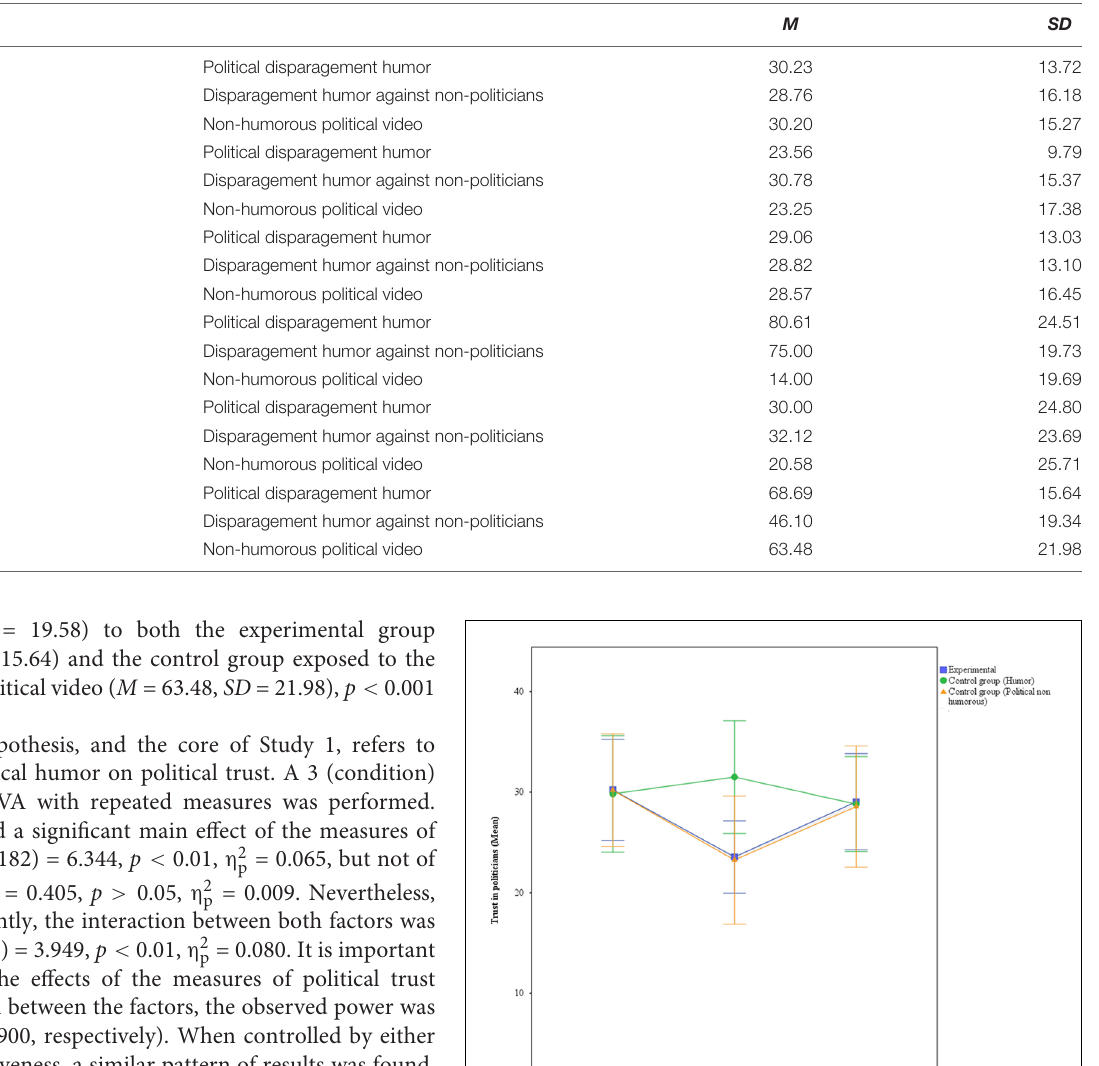
TABLE 3 | Means and standard deviations for trust times 1, 2, and 3, funniness, aversiveness, and cognitive elaboration.